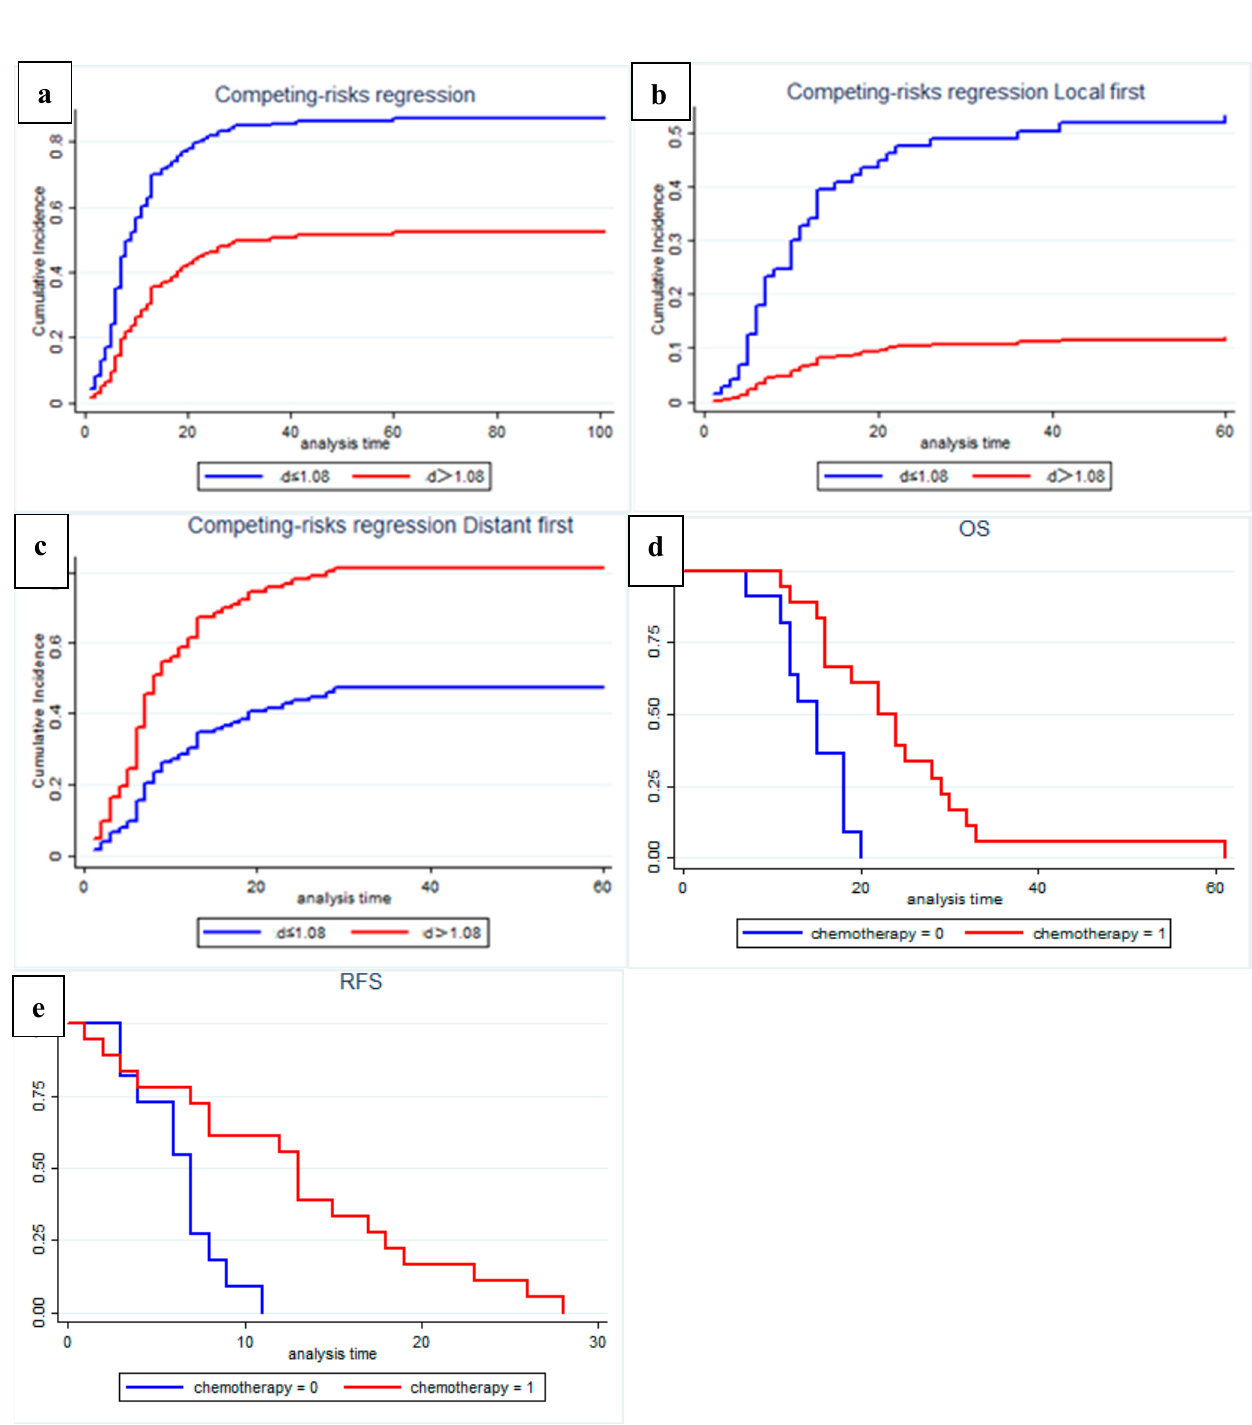
Figure 6. Recurrence risk and pattern analysis according to multiparametric quantitative MRI: ( a ) Fine and gray curve show risk of recurrence ( p = 0.001); ( b ) Cause-specific analysis of competing risk of local recurrence pattern ( p = 0.001); ( c ) Cause-specific analysis of competing risk of distant recurrence pattern ( p = 0.001); ( d , e ) Among patients with distant recurrence, patients in the high-D value group who received postoperative chemotherapy may have significantly improved OS ( p = 0.001) and RFS ( p = 0.003).